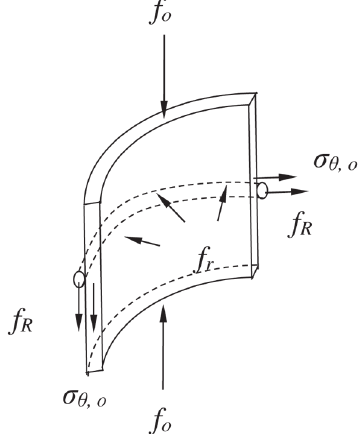
Fig. 3(a). Free body diagram of the outer tube